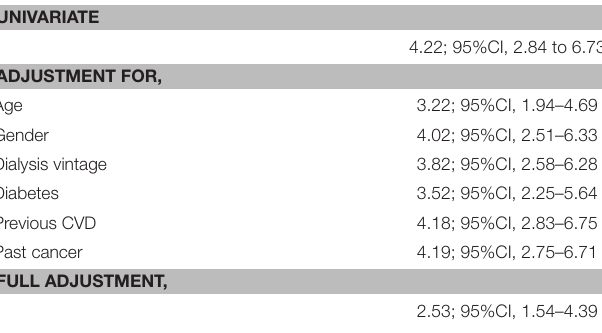
TABLE 4 | Association between log RTE and death, unadjusted, bivariate analysis, and full adjusted.